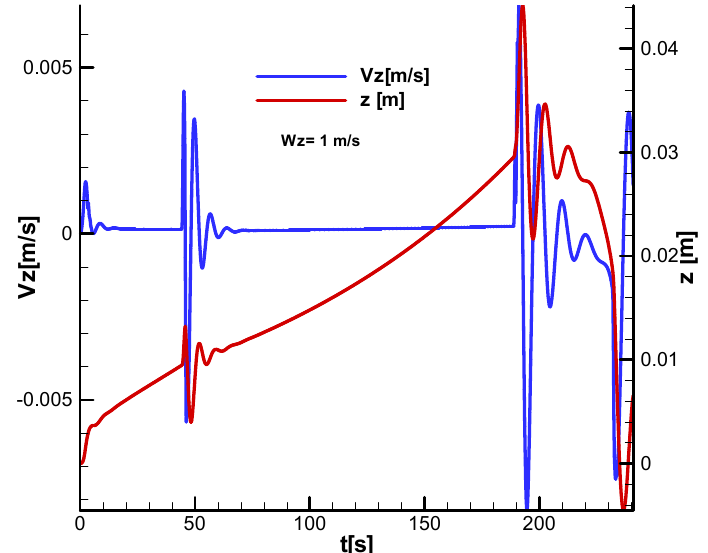
Figure 28. Influence of lateral wind on the lateral coordinate ( z ) and corresponding velocity ( Vz ). Further, we consider a layer of turbulence between the altitude of 200–250 m. This layer of turbulence influences the motion in the ascending and descending phases, as seen in Figure 29.